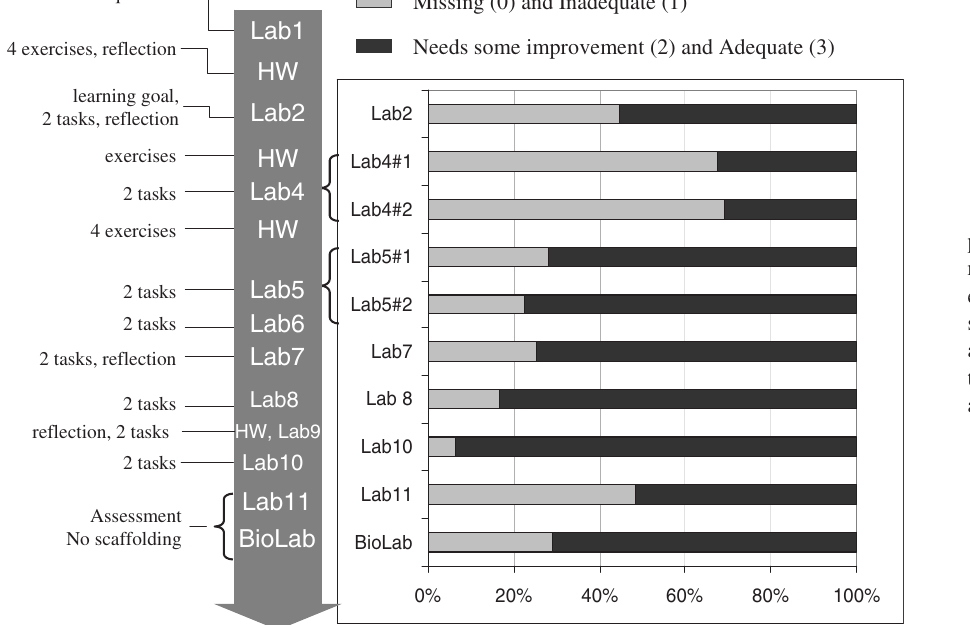
FIG. 3. Ability to evaluate ex- perimental uncertainty. Laborato- ries 4 and 5 had two experiments each, scored separately. The shaded bars represent the percent- age of the students whose labora- tory reports received scores shown at the top of the